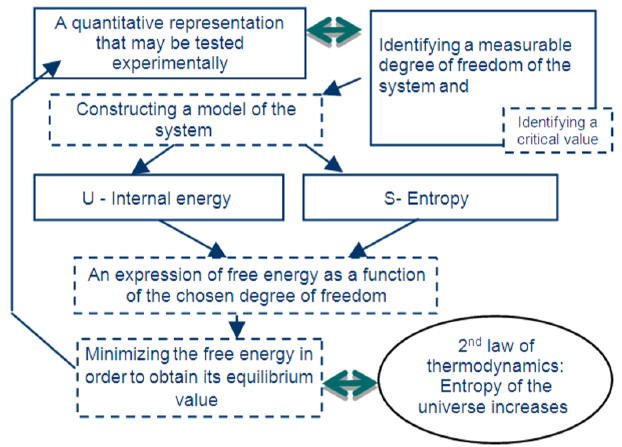
FIG. 4. A flow chart representing the modeling process — a scaffold in the original soft matter